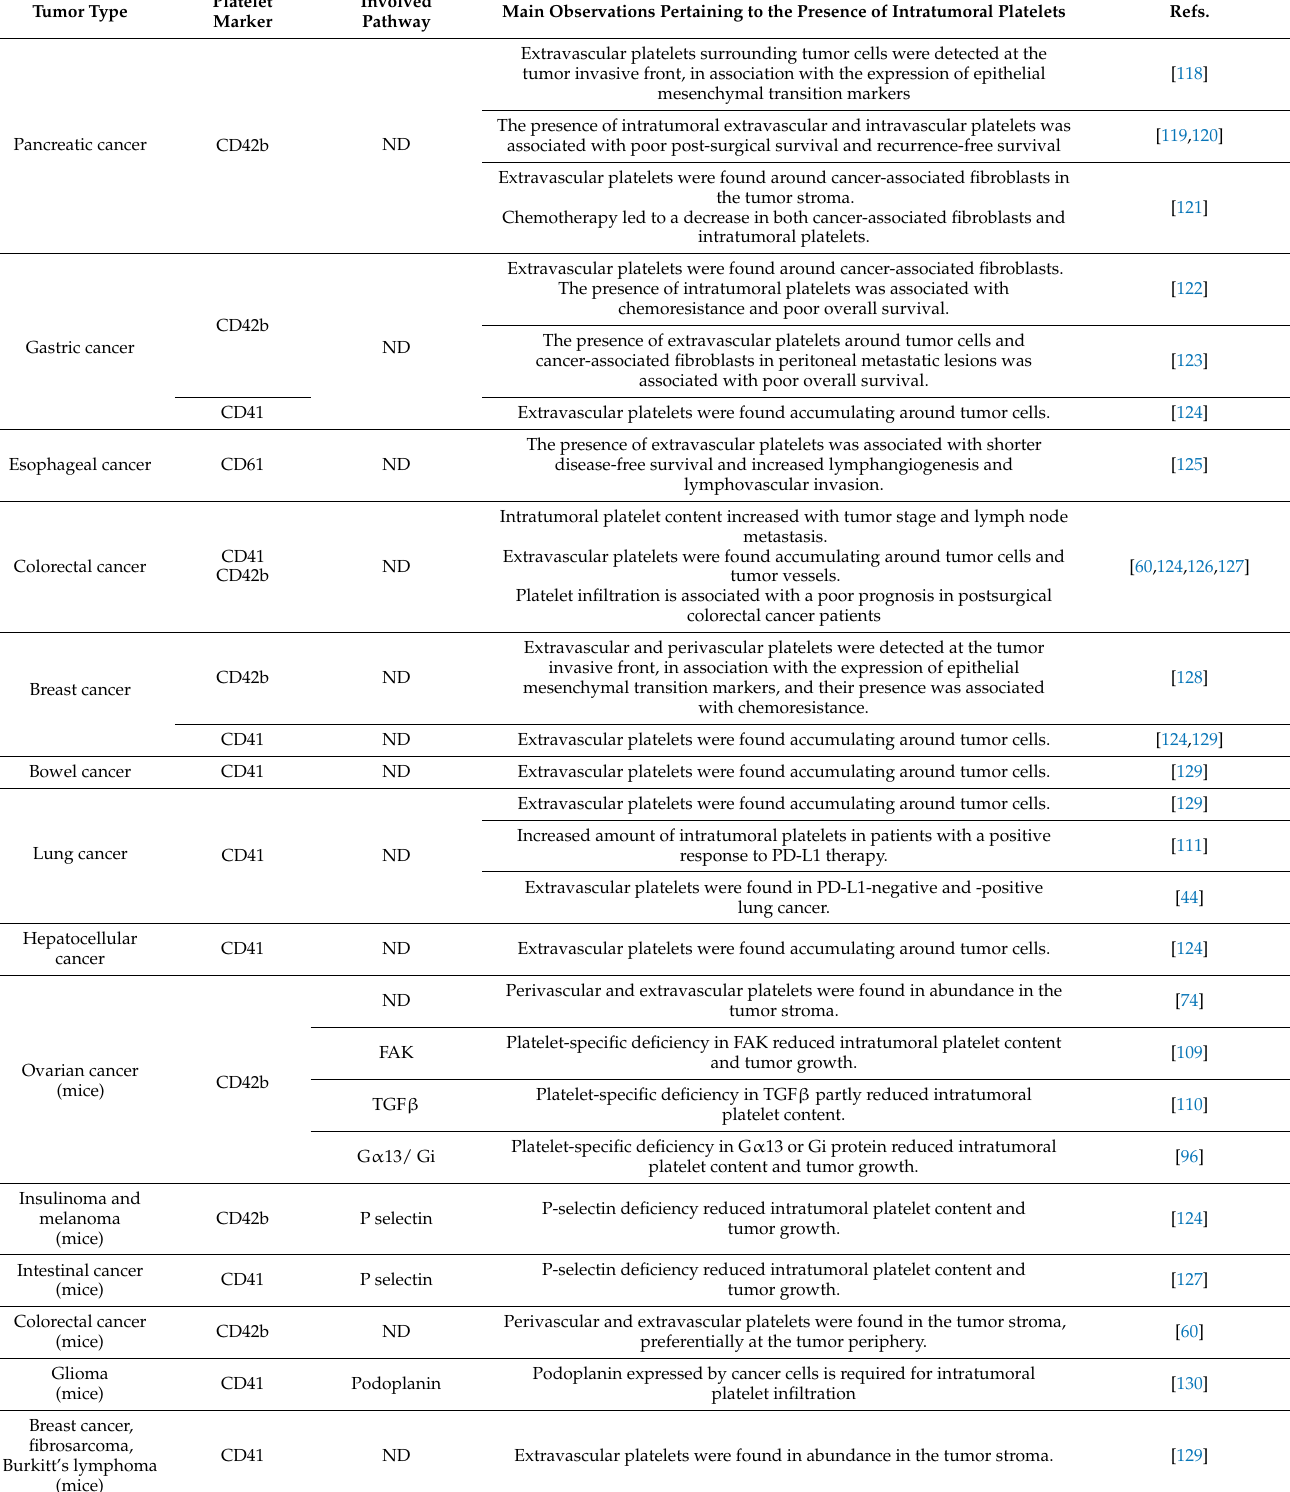
Table 1. Clinical and preclinical reports of intratumoral platelet